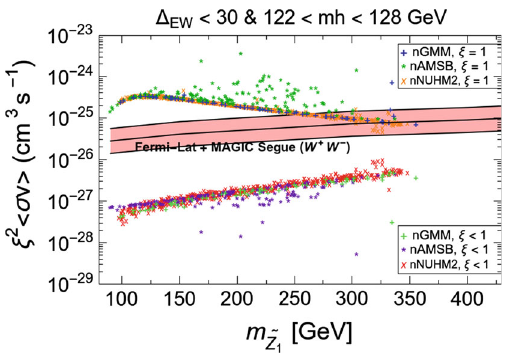
Fig. 4 The scaled values ξ 2 (cid:11) σv (cid:12) from scans over the parameter space of the the natural NUHM2, nGMM and nAMSB models for ξ < 1, assumingtheneutralinorelicdensityisgivenbyitsthermalvalue(lower set), and ξ = 1 (upper set). We plot the Fermi-LAT + MAGIC bound including the central value along with a possible factor of two uncer-